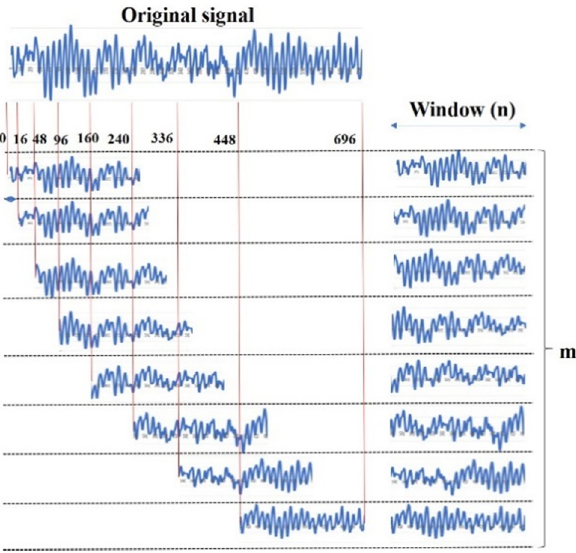
Figure 1: Detailed operation of dislocation.